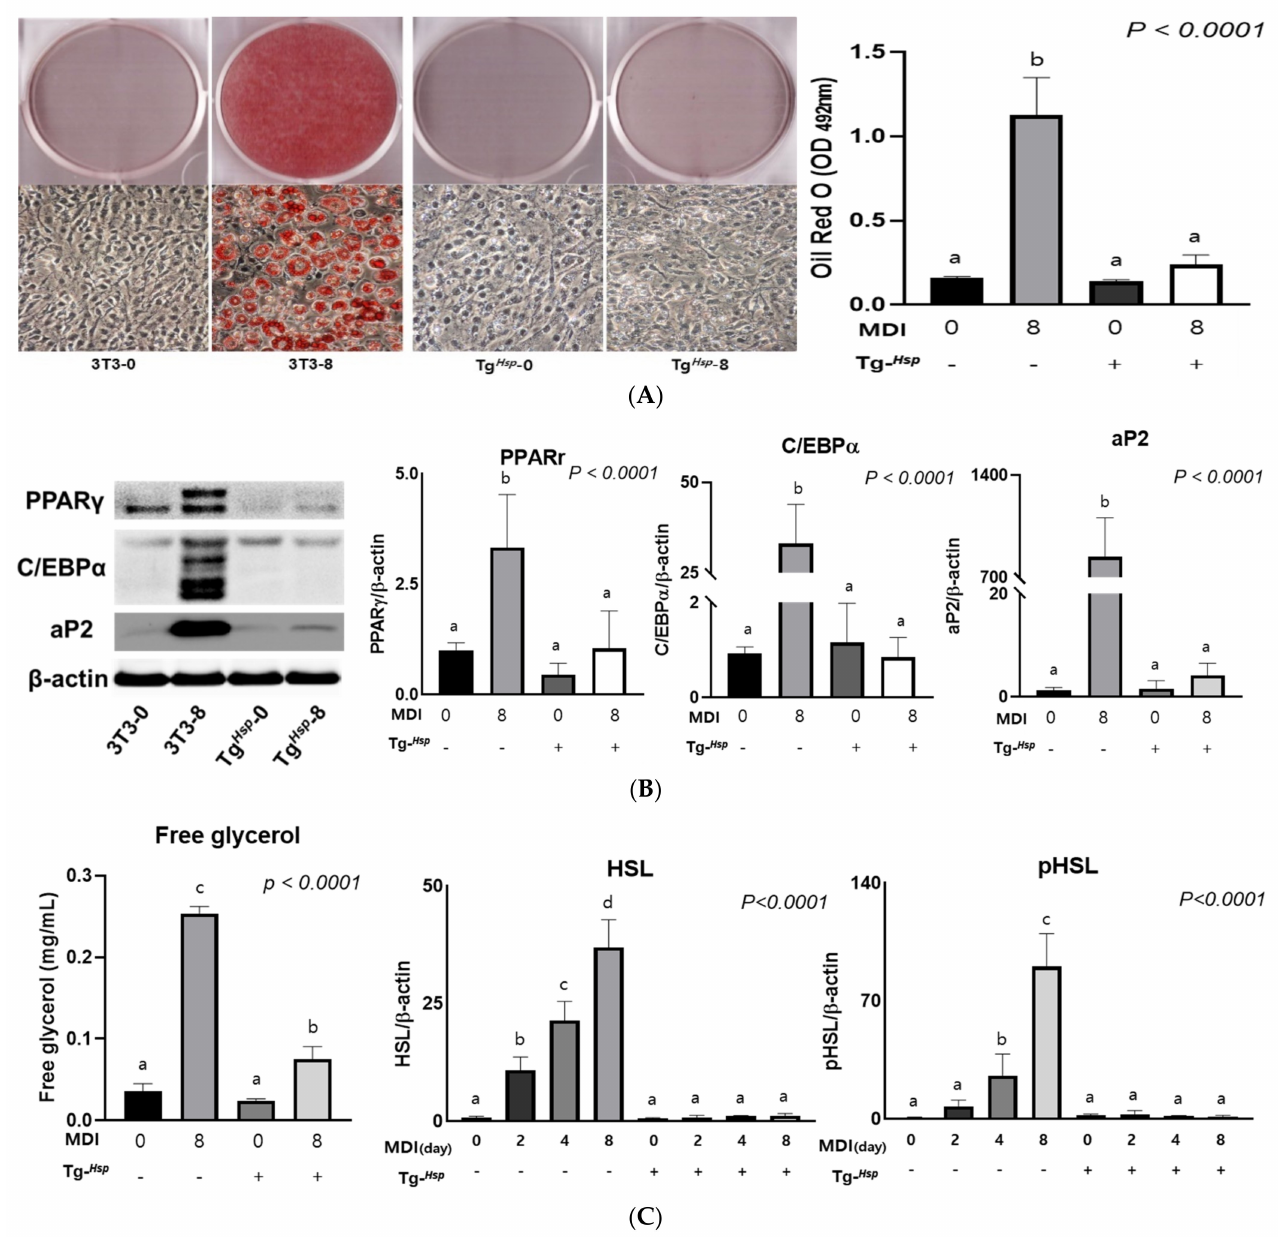
Figure 2. Effect of Tg Hsp in 3T3 − L1 cells on lipid accumulation and lipolysis. ( A ) ORO staining on Days 0 and 8 of differentiation in 3T3-L1 and Tg Hsp cells. Absorbance of extracted ORO solution was measured at 492 nm. ( B ) Expression of adipogenesis biomarkers in 3T3-L1 and Tg Hsp cells. ( C ) Cell culture media were assayed for free glycerol. HSL activation was assessed on Days 0 and 8 of differentiation. The data are presented as means ± SDs of at least three replicates. Means with different superscripts are significantly different at p < 0.05 by Duncan’s multiple range